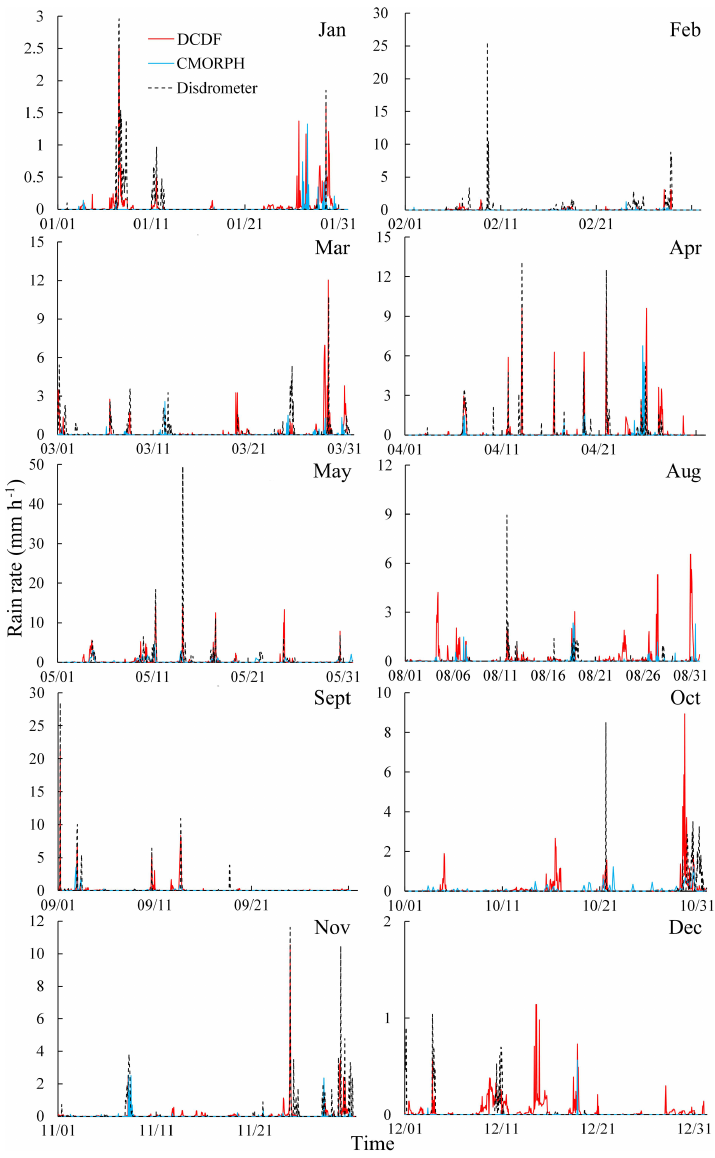
Figure 6. Time series of disdrometer data, original CMORPH and DCDF precipitation at an hourly scale in 2014.